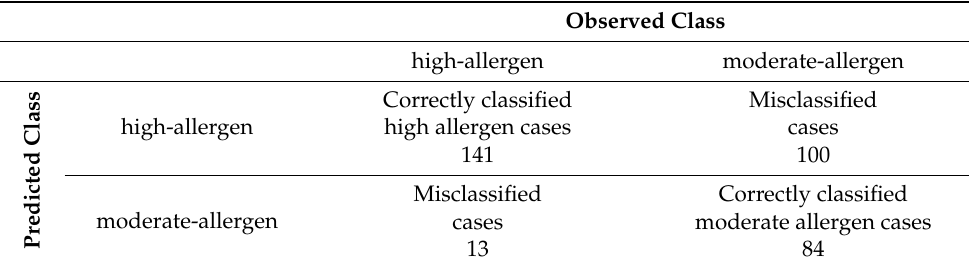
Table 3. Confusion matrix applied to determine Pla a 1 model accuracy.